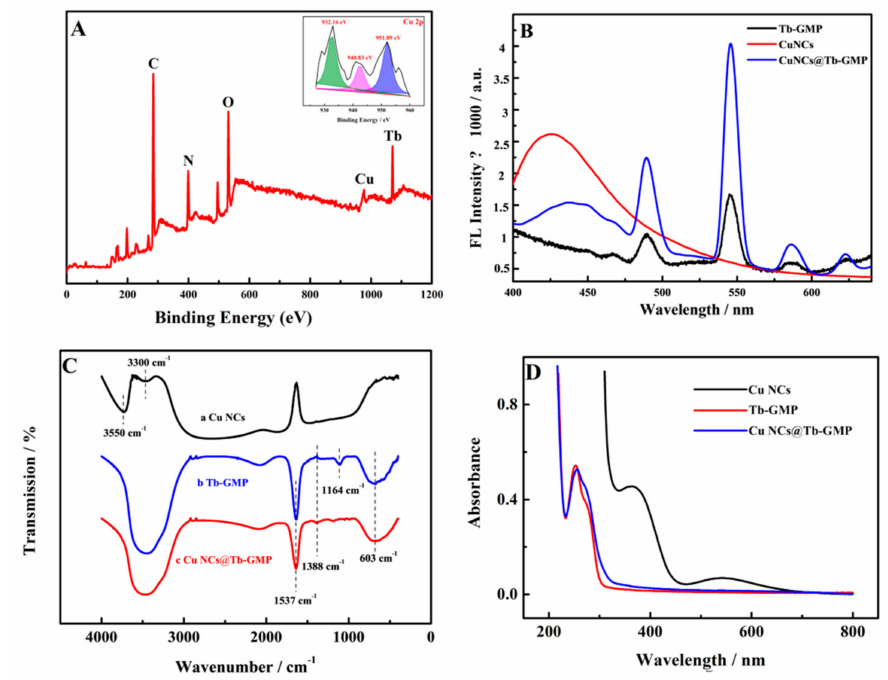
Figure 2. ( A ) The XPS spectrum of Cu NCs@Tb-GMP with the Cu 2p region (inset). ( B ) The fluorescence properties of the Cu NCs (red curve), Tb-GMP (black curve) and Cu NCs@Tb-GMP (blue curve). ( C ) The FT-IR spectra of the Cu NCs (black curve), Tb-GMP (blue curve) and Cu NCs@Tb-GMP (red curve). ( D ) The UV–vis absorption spectra of the Cu NCs (black curve), Tb-GMP (red curve) and Cu NCs@Tb-GMP (blue